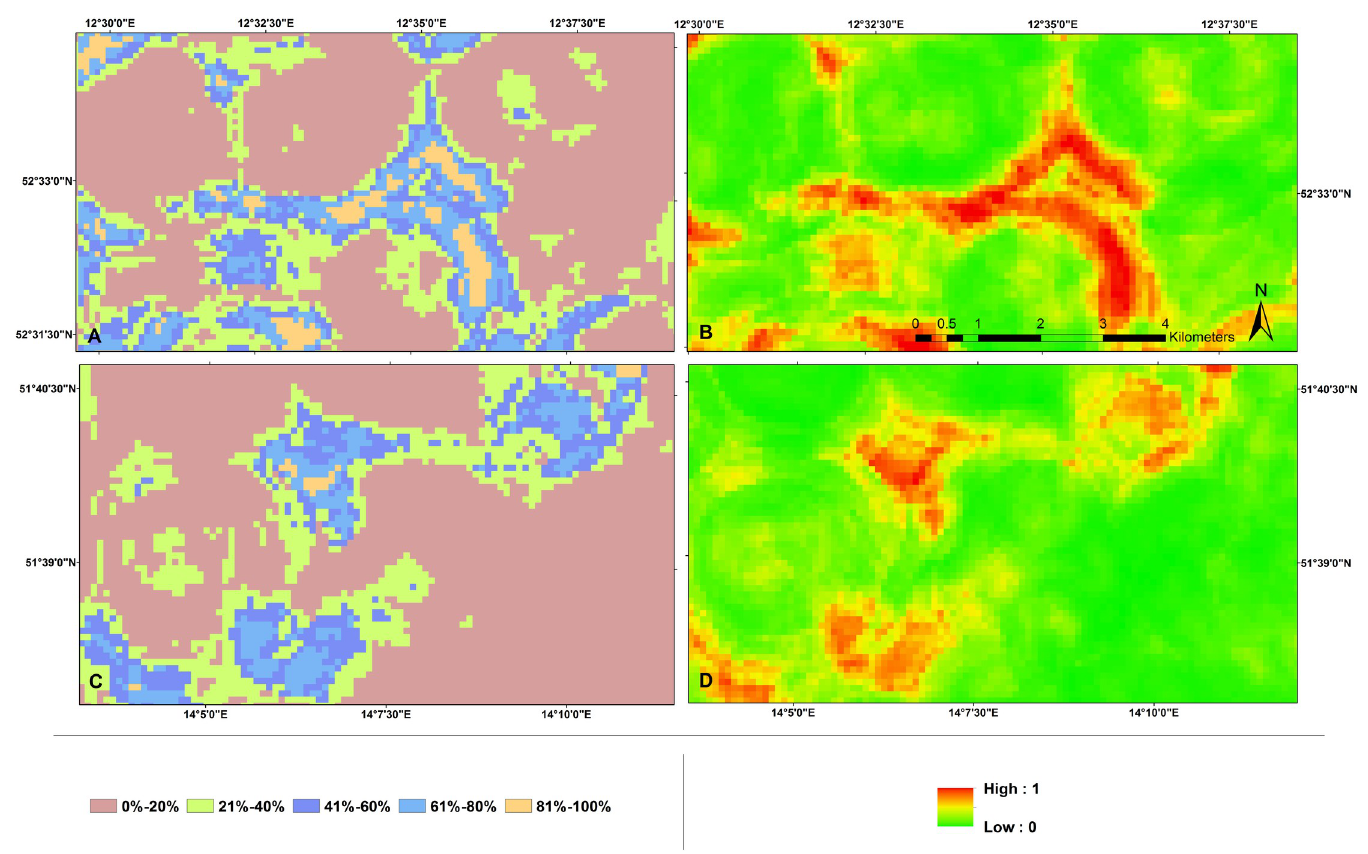
Fig 8. Strike susceptible locations for Buzzards at WTs in the study region of Brandenburg,